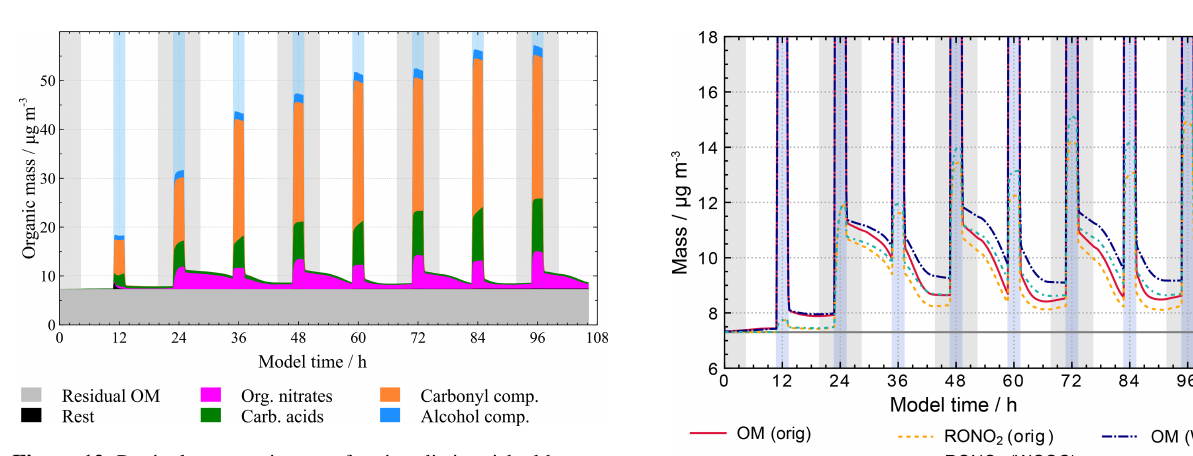
Figure 12. Particulate organic mass fraction distinguished by con- stituents in the base scenario “orig” using the preliminary mech- anism from Sect. 3.1 under urban summer conditions with eight cloud passages. Cloud passages are shaded blue and night-time pe- riods are shaded grey.